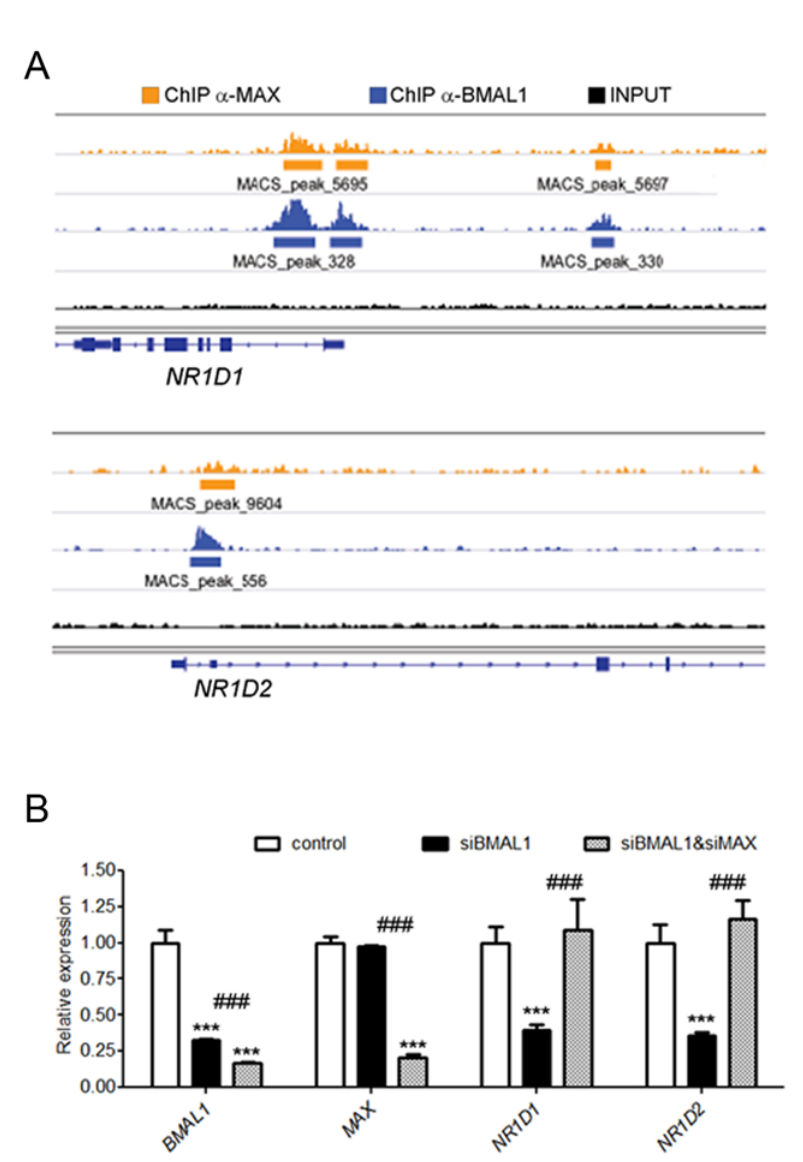
Figure 4. MAX regulates REV-ERB expression. ( A ) Genomic snapshots of the promoter region of the circadian repressor genes, NR1D1 (also known as REV-ERB α ) and NR1D2 (also known as REV-ERB β ) showing the enrichment of MAX (orange) and BMAL1 (blue) ChIP-seq signals. ( B ) Expression of NR1D1 and NR1D2 in MDA-MB-231 cells upon the knockdown of either BMAL1 (siBMAL1) or BMAL1 and MAX (siBMAL1 and siMAX). Relative expression was determined by qRT–PCR using GAPDH for normalization. Values of control cells were set to 1. Shown as mean fold change versus control + SEM, n = 3. Two-way ANOVA with Bonferroni post hoc test is shown. *** p < 0.001, silenced versus control cells, and ### p < 0.001, MAX -silenced versus BMAL1 -silenced cells.